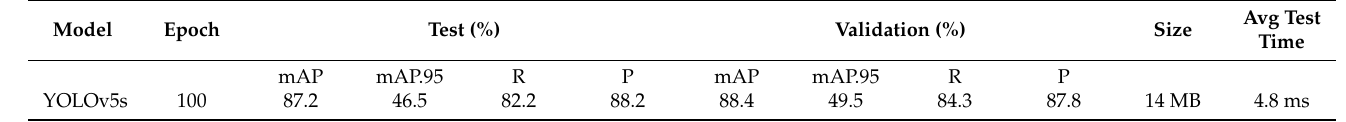
Table 3. Results.